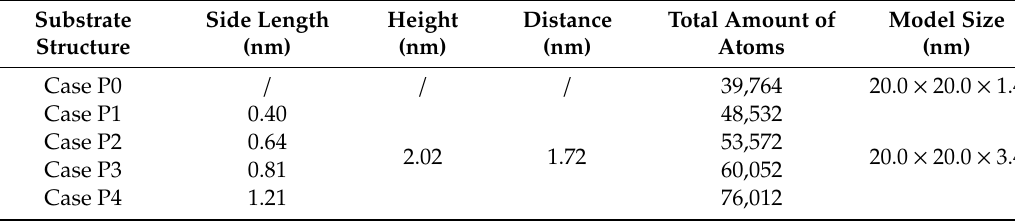
Table 2. Main parameters of metal substrates with smooth surface and rough structure. The total amount of atom is counted according to the model from the Al